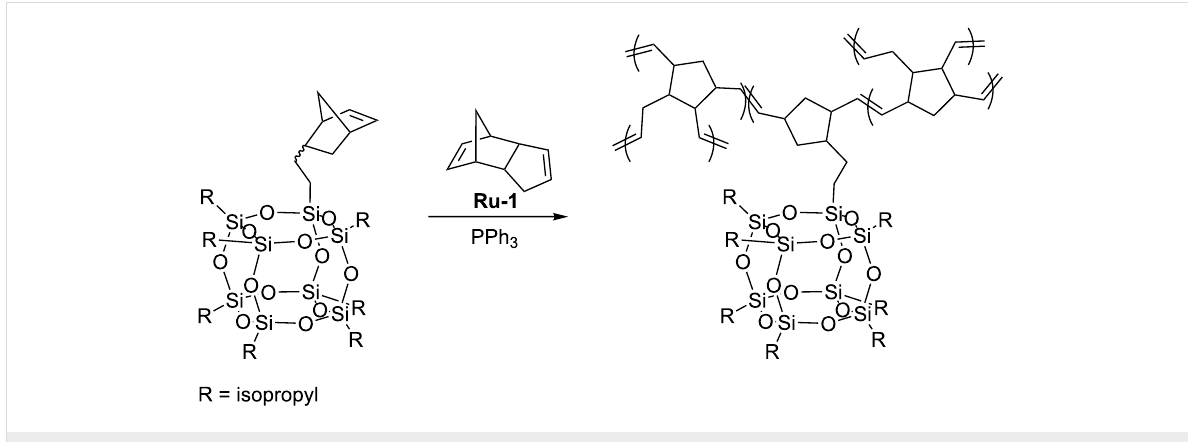
Scheme 23: Copolymerization of POSS-functionalized norbornene with DCPD.